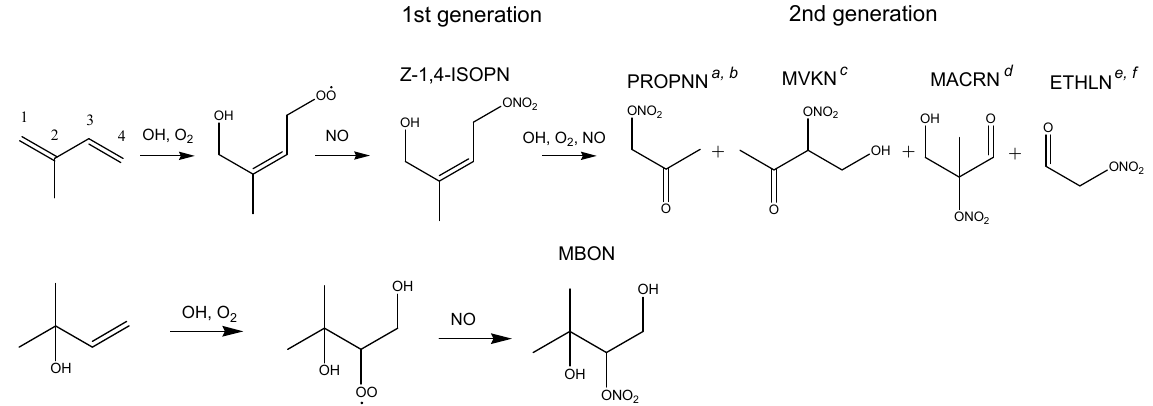
Fig. 1. Organic nitrates from isoprene and MBO photooxidation observed in this study. Only one isoprene hydroxynitrate from the eight possible isoprene nitrate isomers is shown here. Only ETHLN forms from the isoprene hydroxynitrate isomer shown here. The other second generation nitrates can form from the isomers indicated by the superscripted letters (a: 4,1-ISOPN; b: 2,1-ISOPN; c: 4,3-ISOPN; d: 1,2- ISOPN; e: 3,4-ISOPN; f: 1,4-ISOPN,